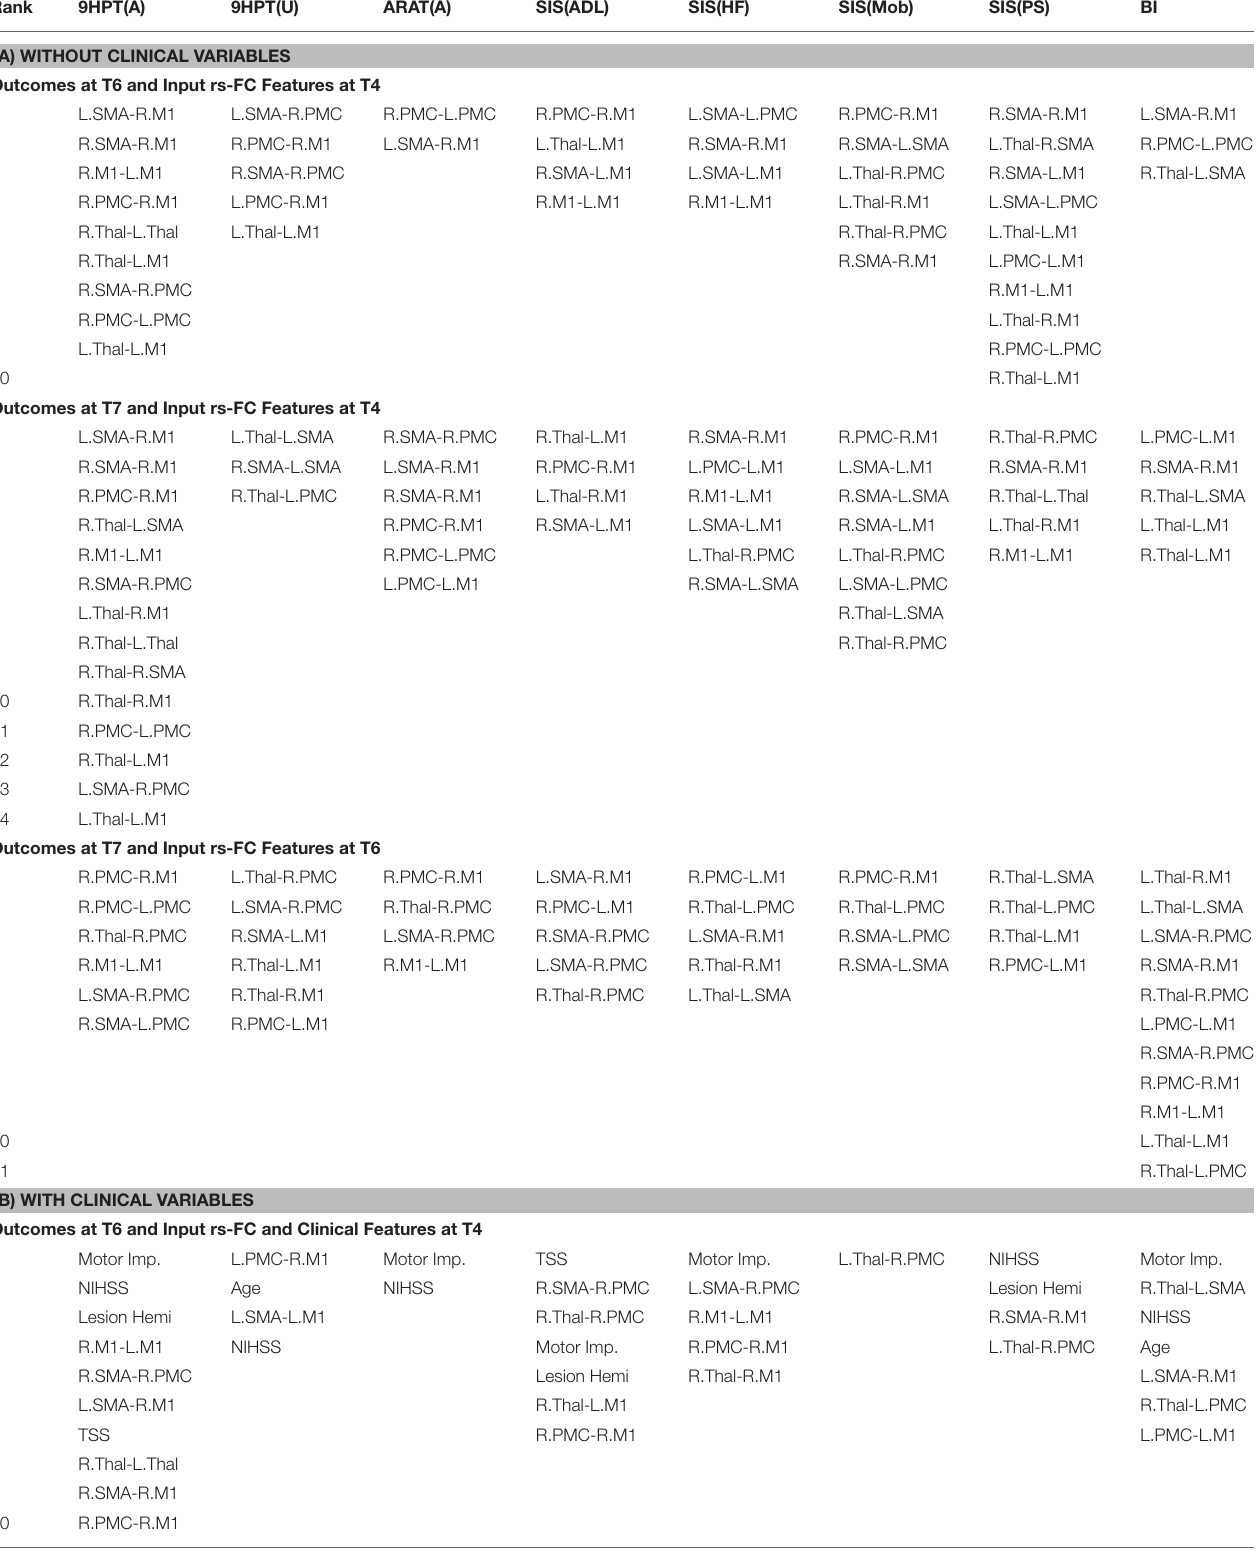
TABLE 5 | List of rs-FC correlates of behavior between all pairs of time-points identified by using linear-kernel SVR are presented below. Rank 9HPT(A) (A) WITHOUT CLINICAL VARIABLES Outcomes at T6 and Input rs-FC Features at T4